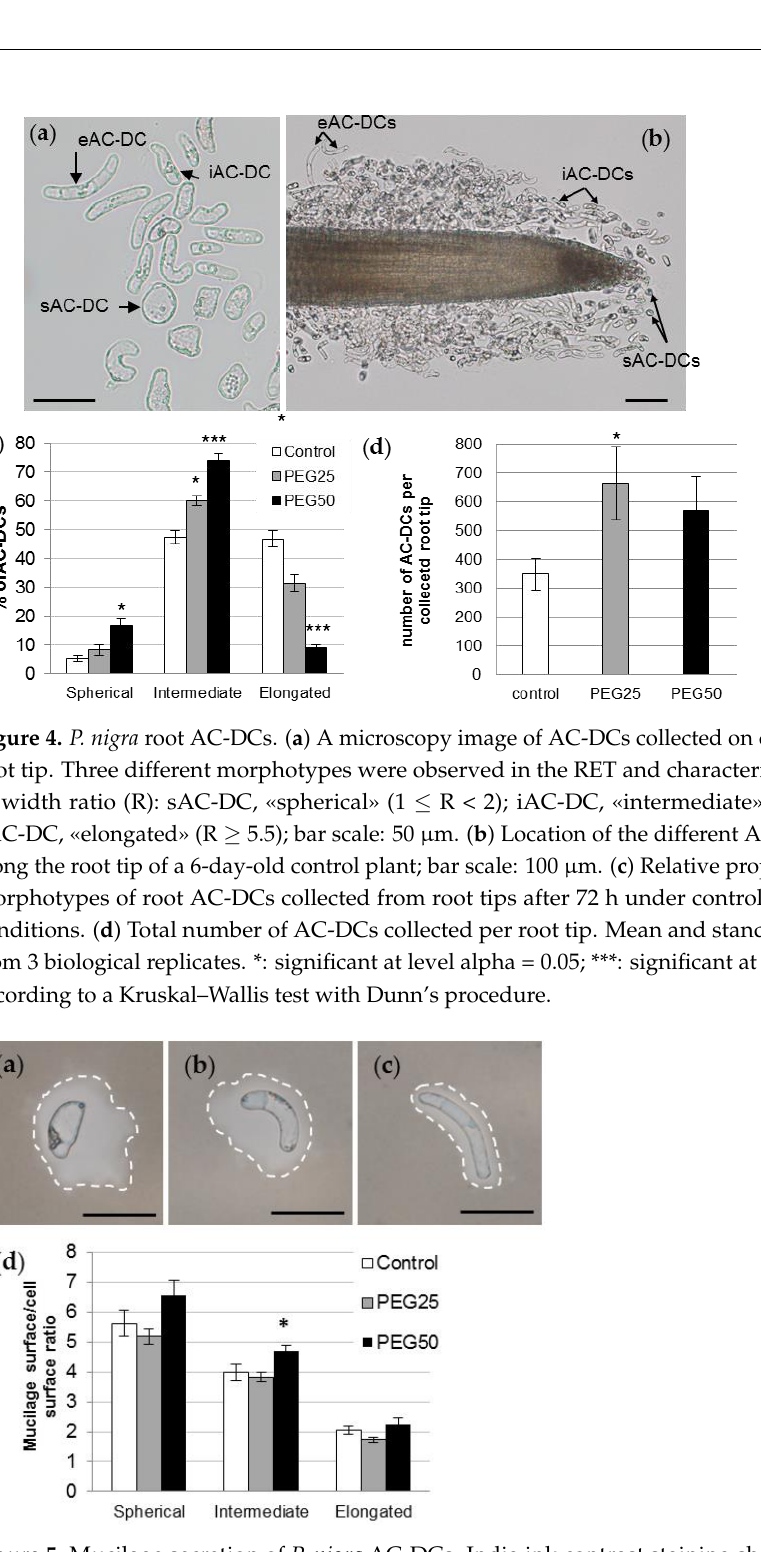
Figure 5. Mucilage secretion of P. nigra AC-DCs. India ink contrast staining showing spherical ( a ), intermediate ( b ), and elongated ( c ) AC-DCs collected on control root tips on day 6. Secreted mucilage is delimited by the dotted line. Bar scale: 50 μ m. ( d ) Mucilage surface/cell surface ratio calculated on isolated spherical, intermediate, and elongated AC-DCs collected after 72 h (day 6) from control and stressed seedlings (mean and standard error from at least 100 cells collected from 10 root tips). * indicates significant difference with the control at level alpha = 0.05 according to a Kruskal – Wallis test with Dunn ’ s procedure.